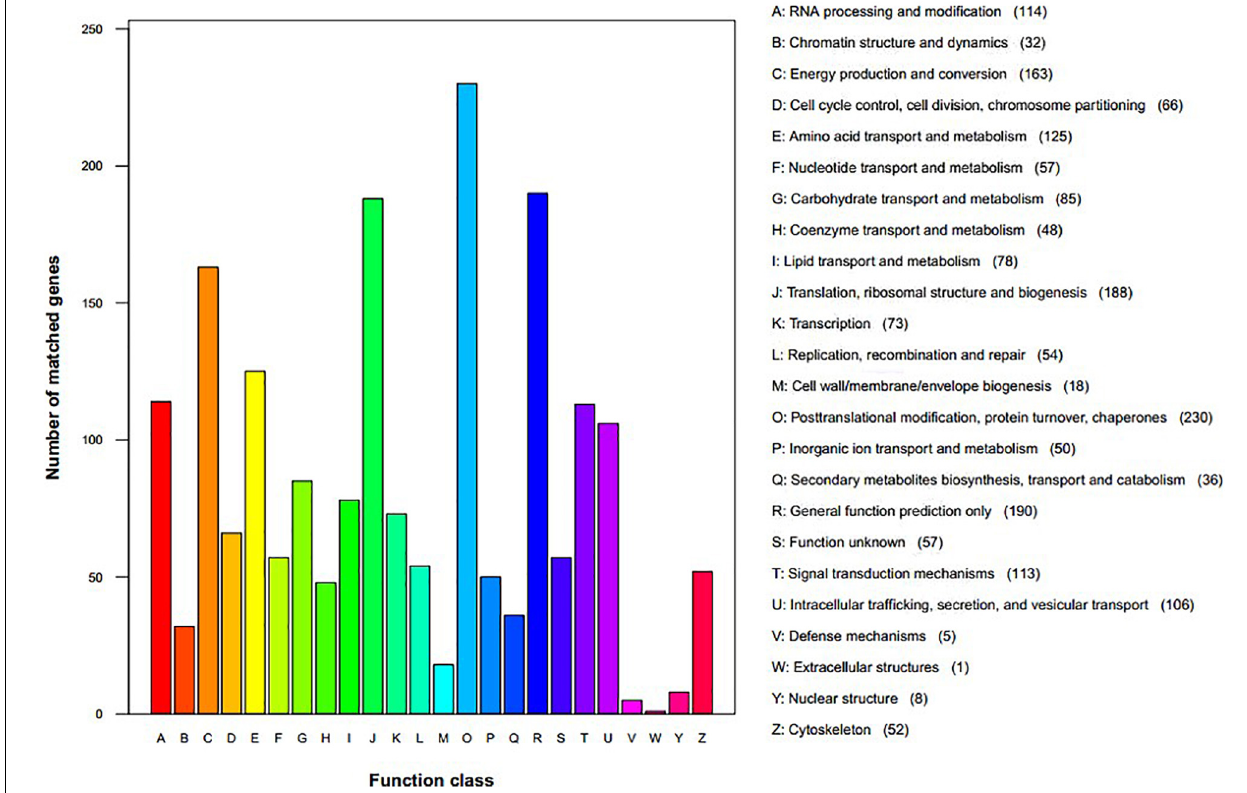
FIGURE 3 | Eukaryotic Orthologous Groups functional classification of Sarcomyxa edulis